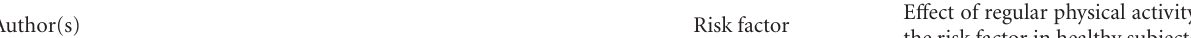
Table 2: Preventive e ff ects of regular physical activity on major risk factors for cardio- and cerebrovascular diseases and cancer.